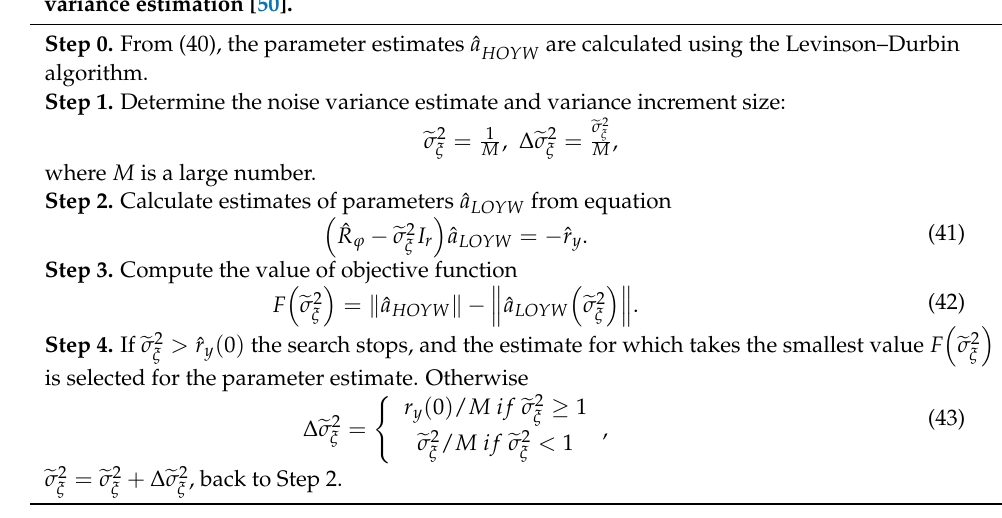
Algorithm 2 [50]. The low order Yule–Walker equations with iterative noise vari- Algorithm 2. The low order Yule-Walker equations with iterative noise ance estimation. variance estimation